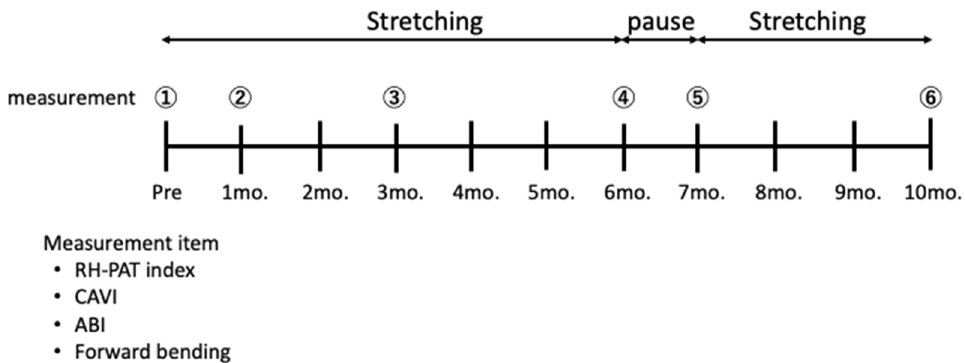
Figure 1. Study protocol. The stretching intervention consisted of six months of daily stretching, one month of rest, and another three months of daily stretching. The arteriosclerosis indices (RHI, CAVI, and ABI) and flexibility (forward-bending value) were measured at baseline and one, three, six, seven, and ten months from the baseline. Abbreviations: RHI, reactive hyperemia index; RH-PAT index: reactive hyperemia peripheral arterialtonometry index; CAVI, cardio ankle vascular index.